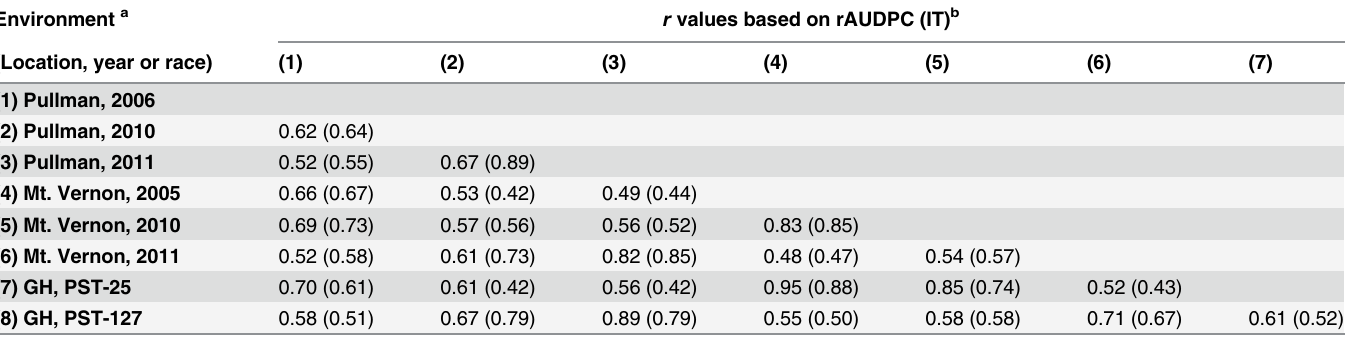
Table 3. Correlation coefficients ( r ) of mean relative area under the disease progress curve (rAUDPC) and infection type (IT) of the Druchamp × Michigan Amber-derived recombinant inbred lines tested in the eight environments. Environment a r values based on rAUDPC (IT) b (Location, year or race)